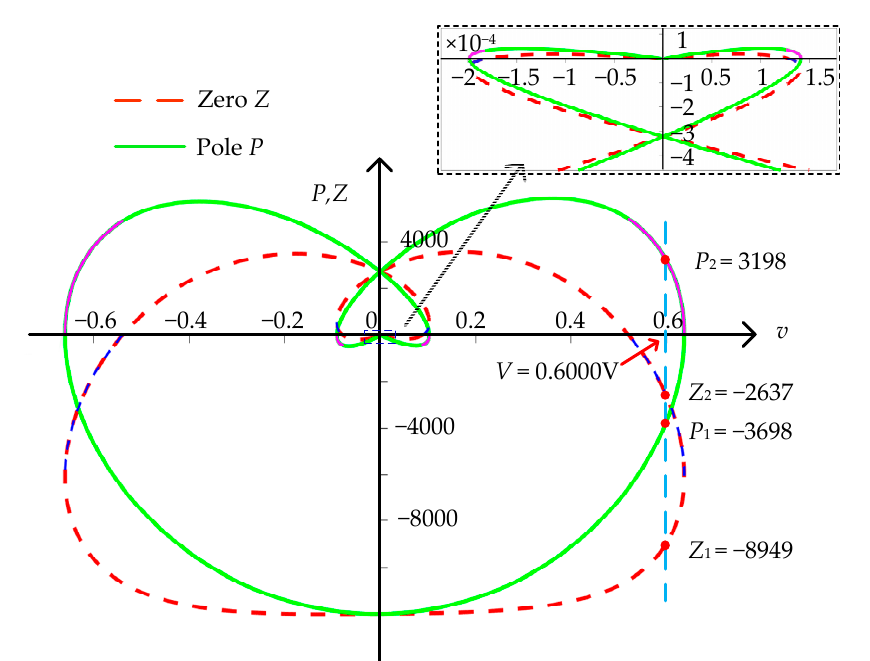
Figure 5 . Zeros and poles of memristor .